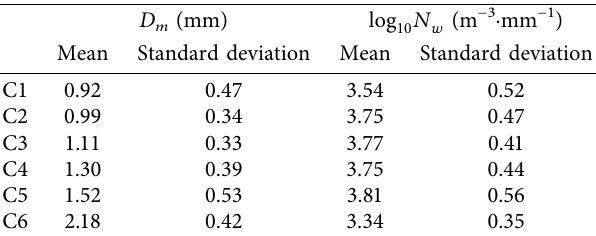
Table 4: Mean and standard deviation values of D different rain rate classes.